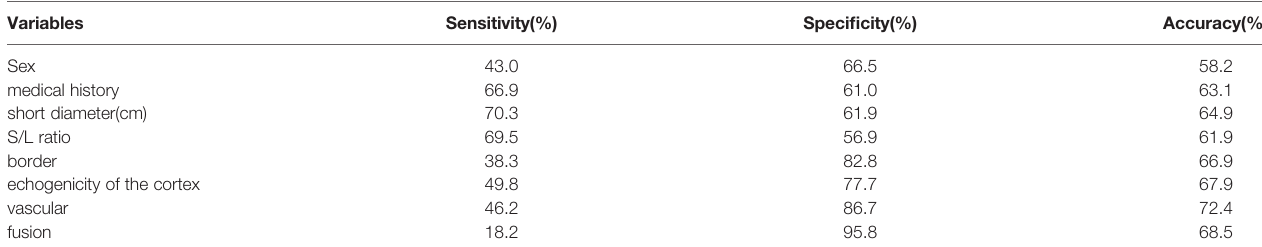
TABLE 4 | Sensitivity, speci fi city, and accuracy of variables in the model. Variables